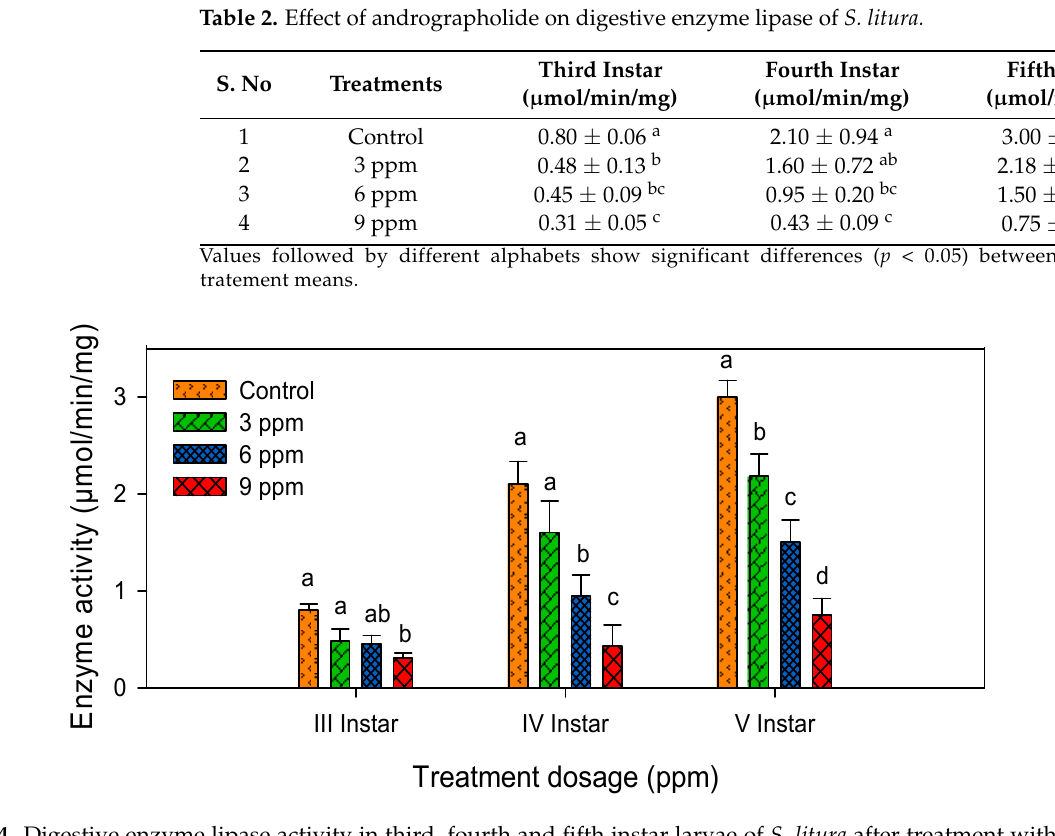
Table 2. Effect of andrographolide on digestive enzyme lipase of S. litura.